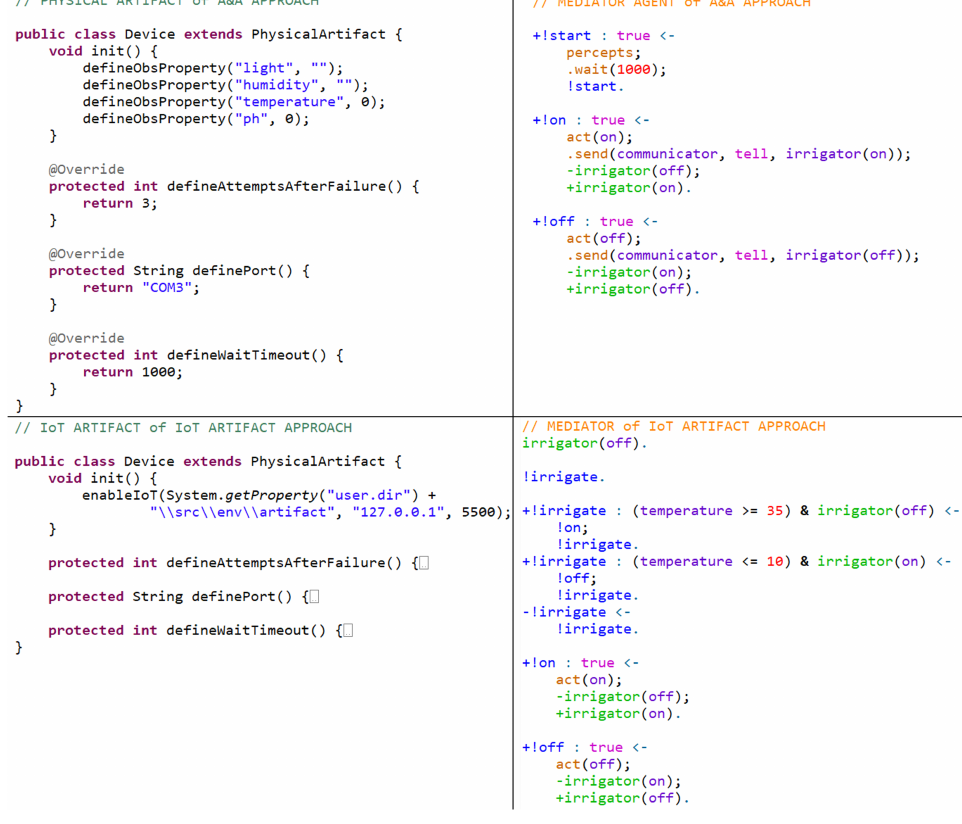
Figure 7. The A&A and IoT Artifact Approach